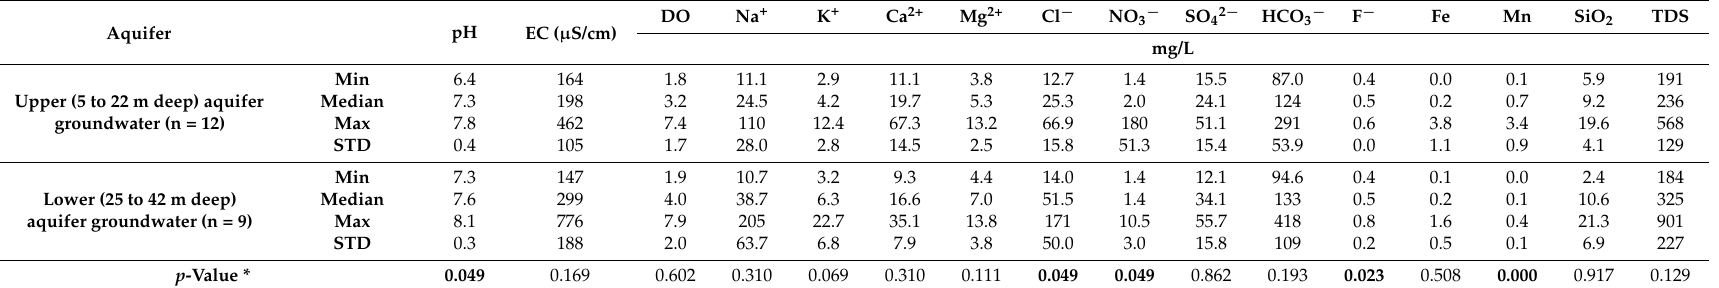
Table 2. Statistical summary of hydrochemical data obtained from multilevel monitoring wells (MLWs) in the study area.